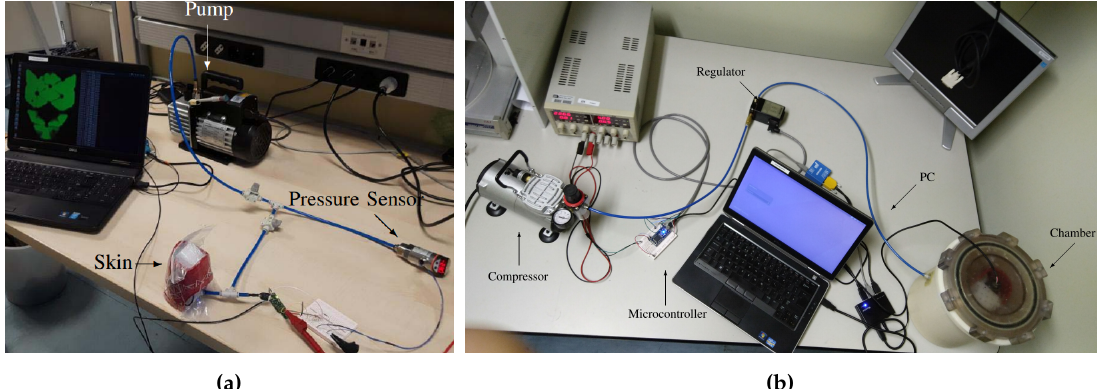
Figure 3. ( a ) Calibration setup based on vacuum bags. ( b ) Calibration setup based on isolation